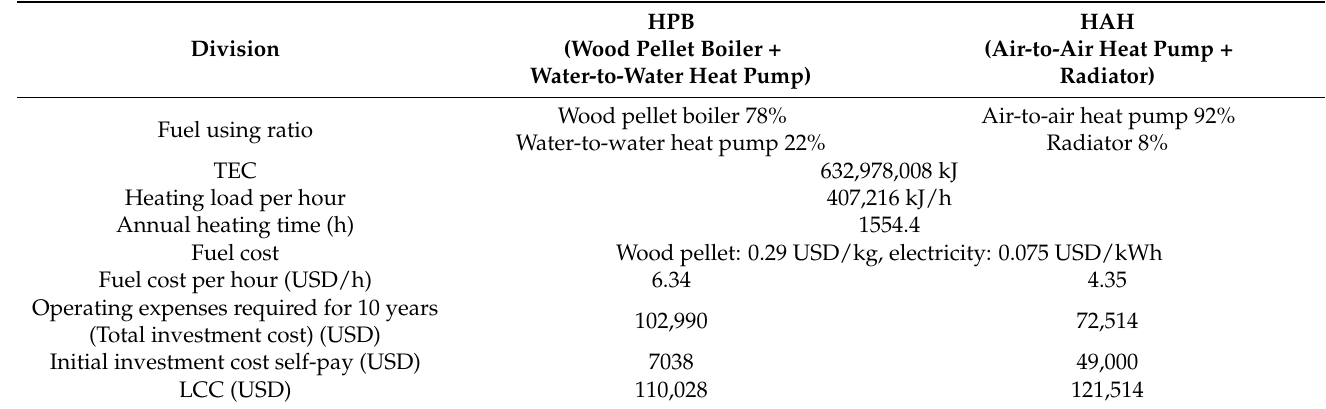
Comparative results of economic analysis using LCC (self-pay) for each system (HPB,